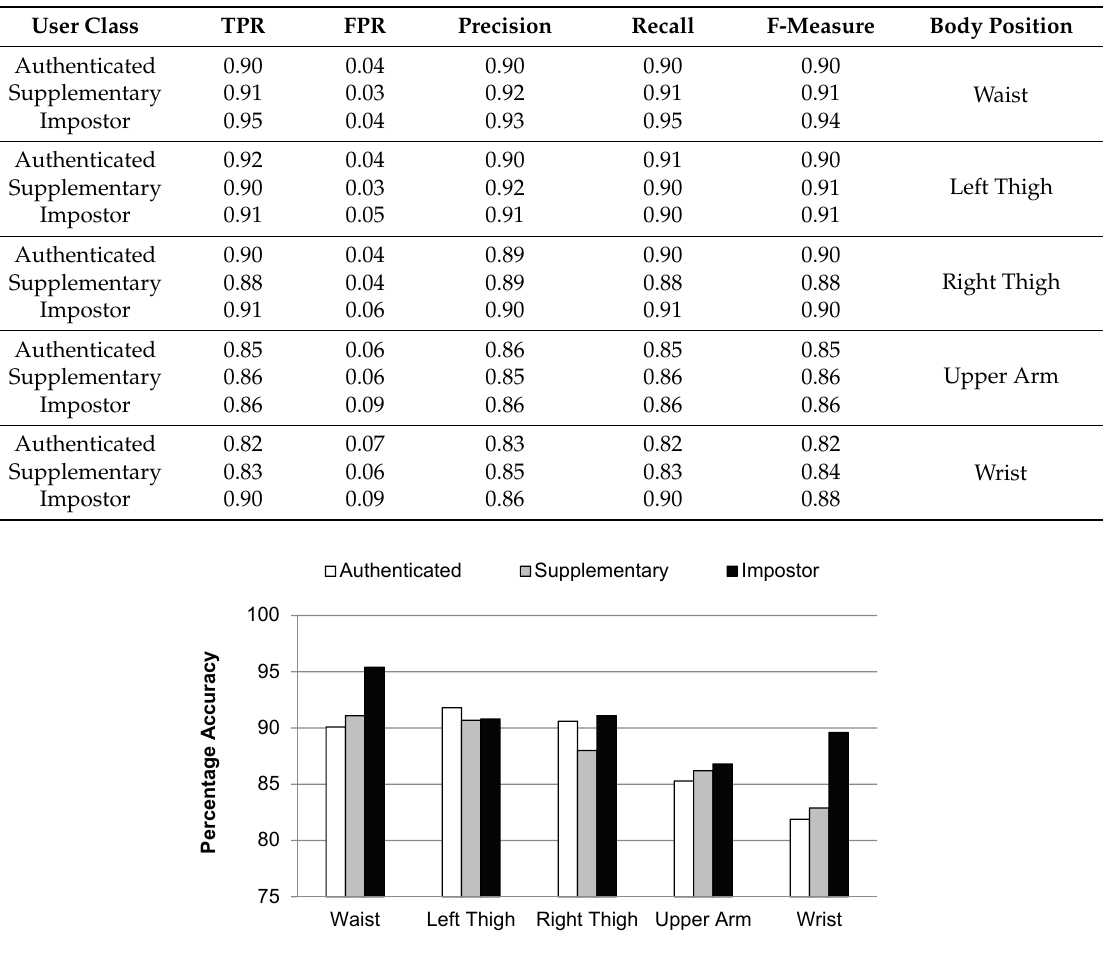
Table 8. Results of user classification based on activity recognition at five body positions.